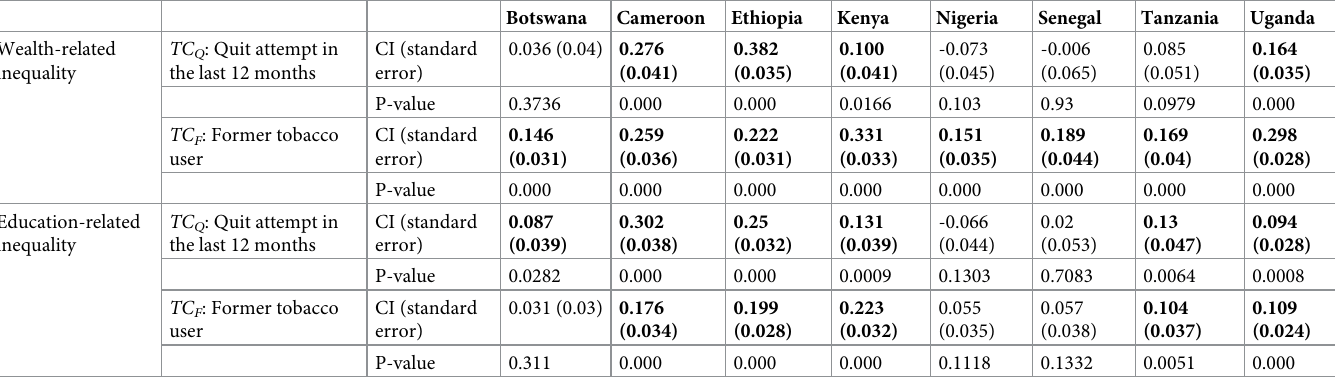
Table 2. Concentration indices for TC Q and TC F across